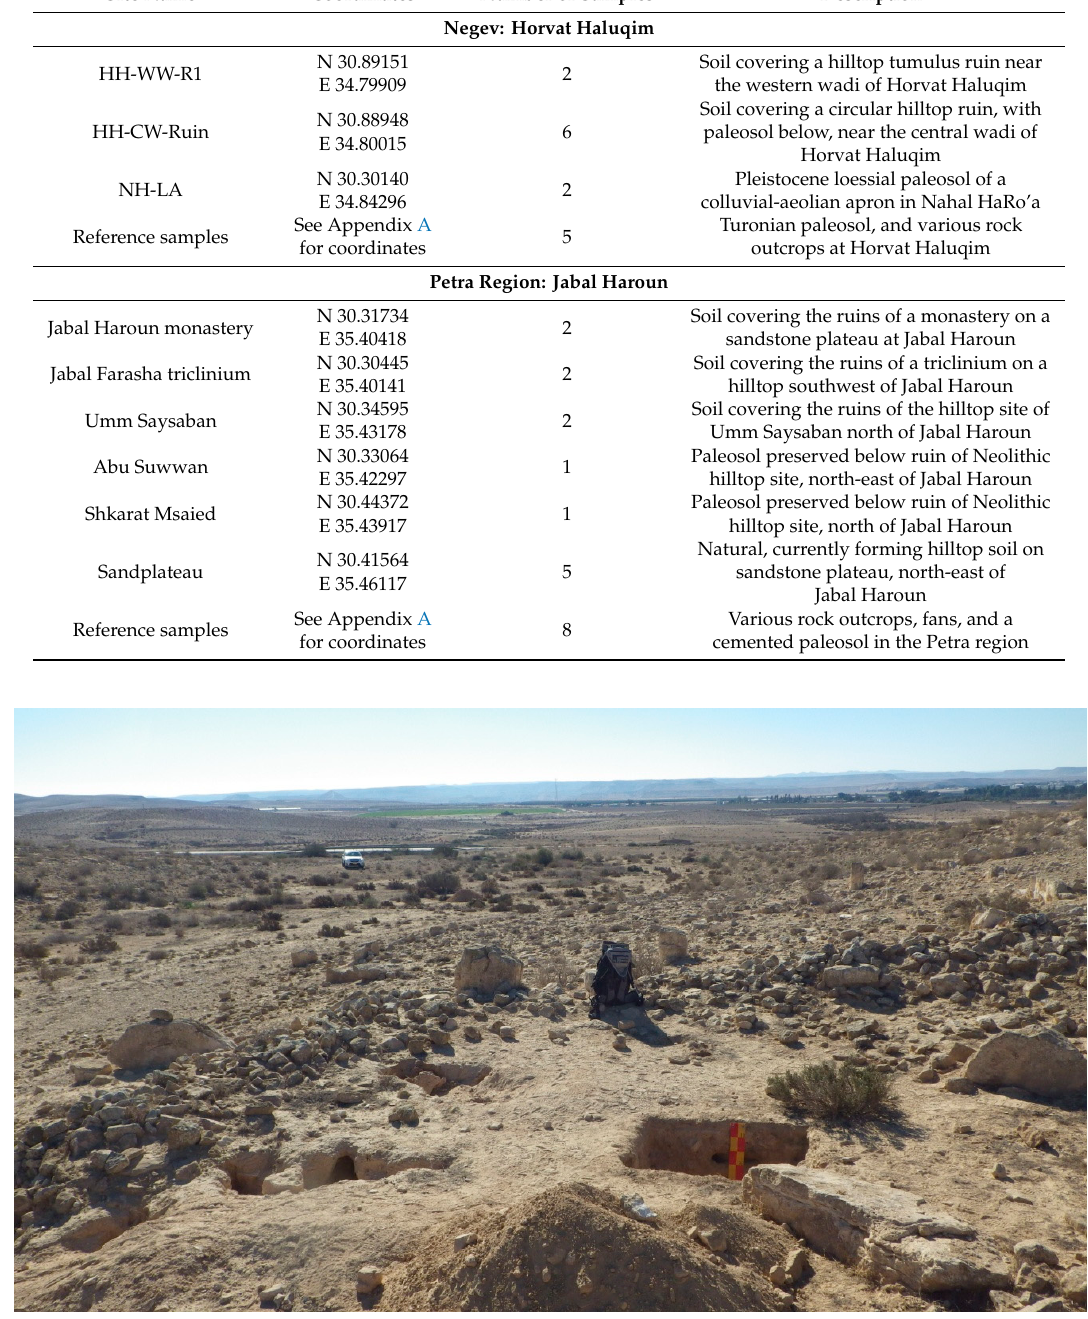
Figure 2. View south from the sampled ruin near the central wadi at Horvat Haluquim, showing the surrounding landscape in the Negev.